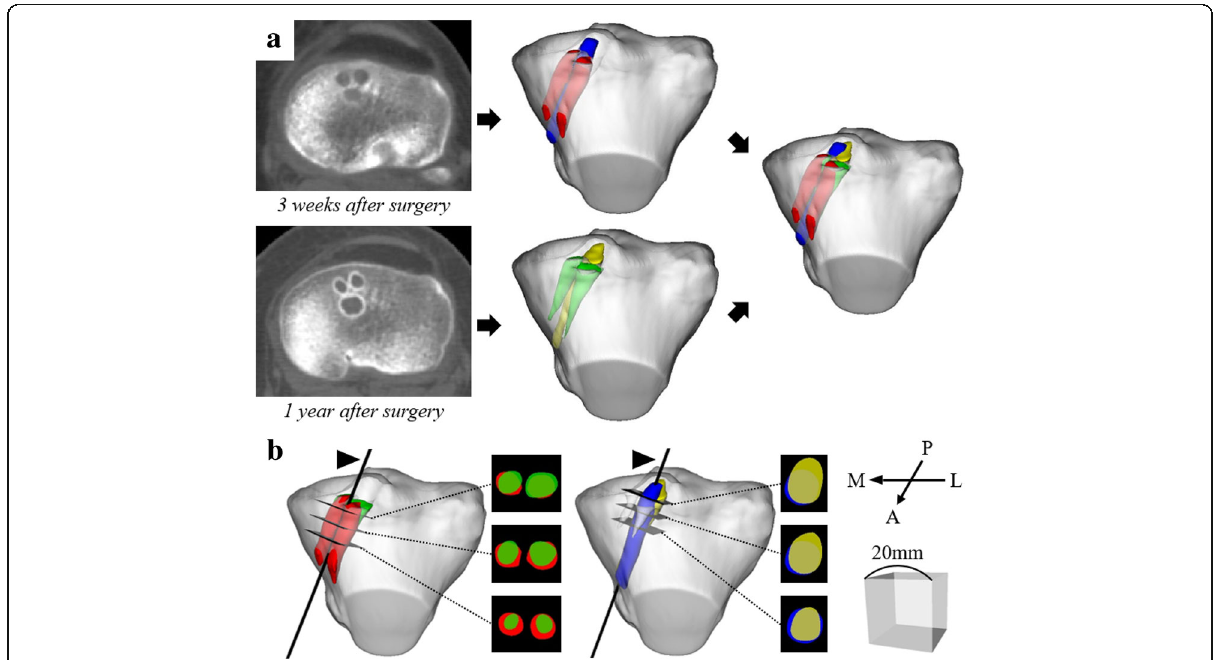
Fig. 1 a Reconstruction and superimposition of the three-dimensional (3D) models of the tibia and the three tibial tunnels at 3 weeks and 1 year after surgery. The red and the green 3D models indicate the two anterior tunnels at 3 weeks and 1 year after surgery, respectively. The blue and the yellow 3D models indicate the posterior tunnel at 3 weeks and 1 year after surgery, respectively. b Measurement of the cross-sectional areas (CSAs) of the tibial tunnels at 3 weeks and 1 year after surgery. The measurement was performed by cutting the 3D models of the two anterior tunnels ( left ) and the posterior tunnel ( right ), along the planes perpendicular to the tunnel axes ( black arrow head ), at the aperture and 5 and 10 mm distal from the aperture. The bottom right cube has a length of 20 mm on each side. M : medial, L : lateral, A : anterior, P :